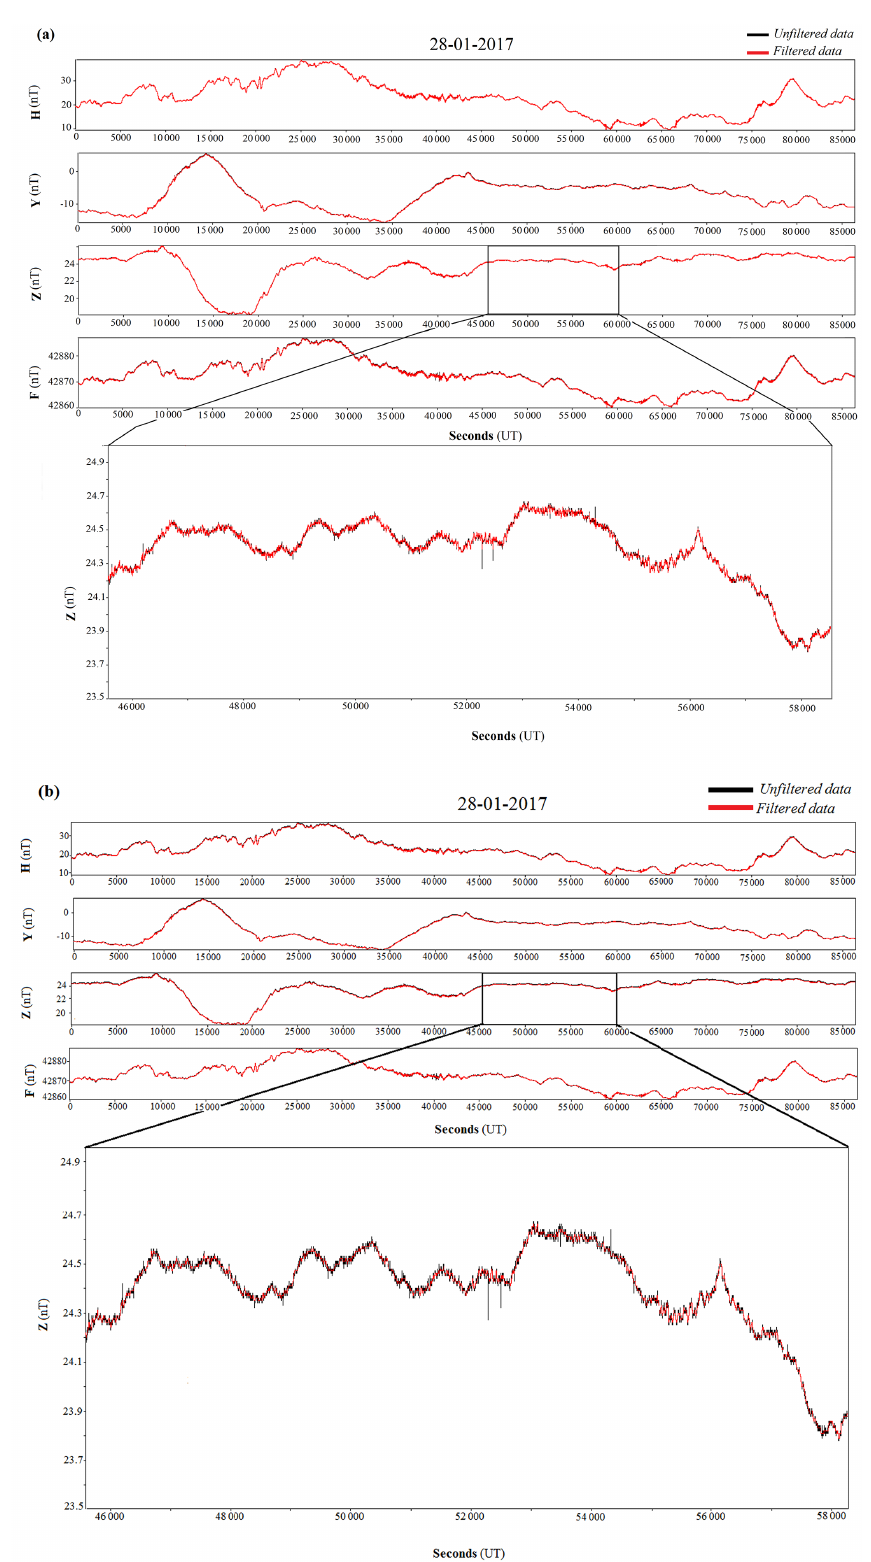
Figure 5. (a) Sample plots of 1s raw (black color line) and filtered data (red color line) with a cutoff frequency of 0.2Hz from the CPL magnetic observatory. (b) Sample plots of 1s raw (black color line) and filtered data (red color line) with a cutoff frequency of 0.005Hz from the CPL magnetic